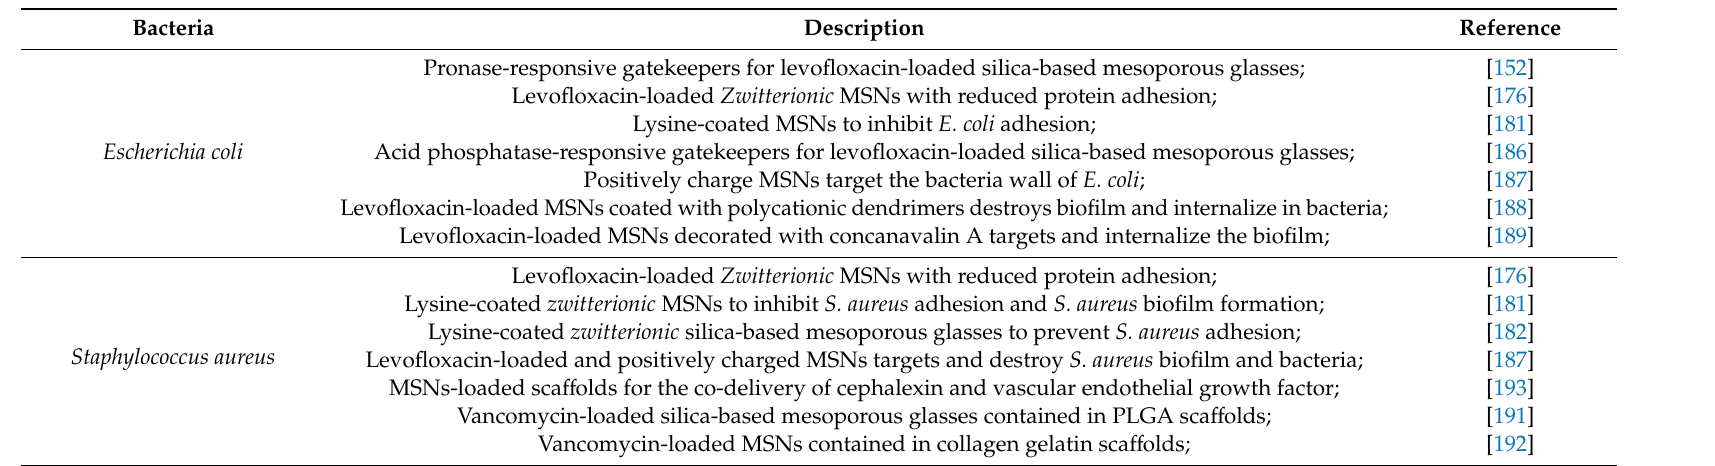
Table 2. Summary of mesoporous silica-based materials against bone